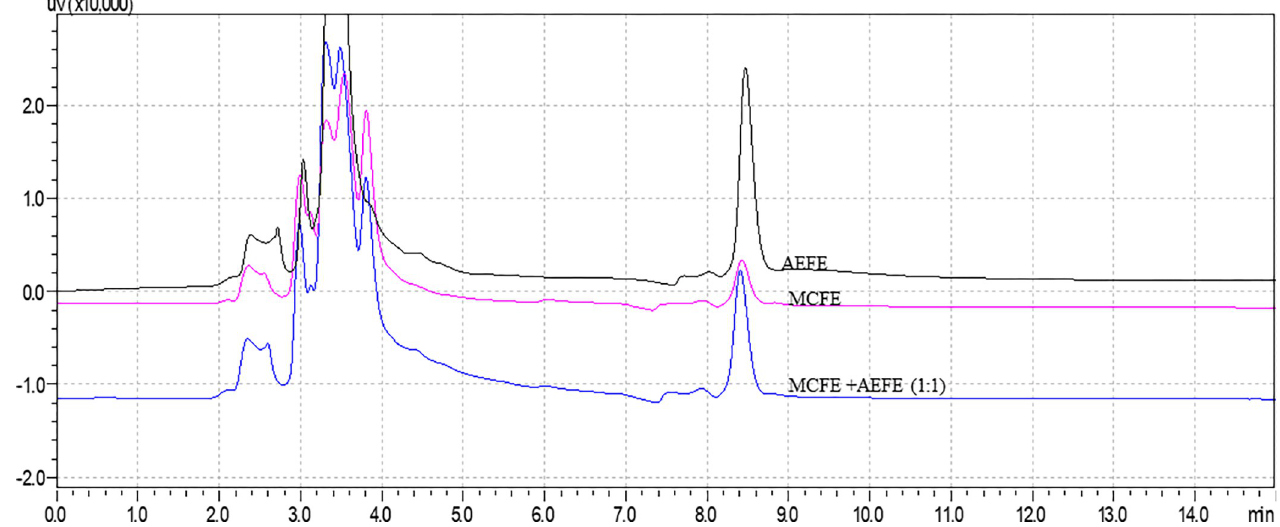
Fig 1. Extract-extract compatibility profile. The black, purple, and blue chromatograms represent chemical fingerprints for AEFE, MCFE, and their binary mixture (1:1). A well-resolved peak was found at approximately 8.5 minutes in all the preparations. Conditions: mobile phase: 0.01% trifluoroacetic acid water: methanol: acetonitrile (30:60:10 v/v); Column C18; Detection: 210 nm.